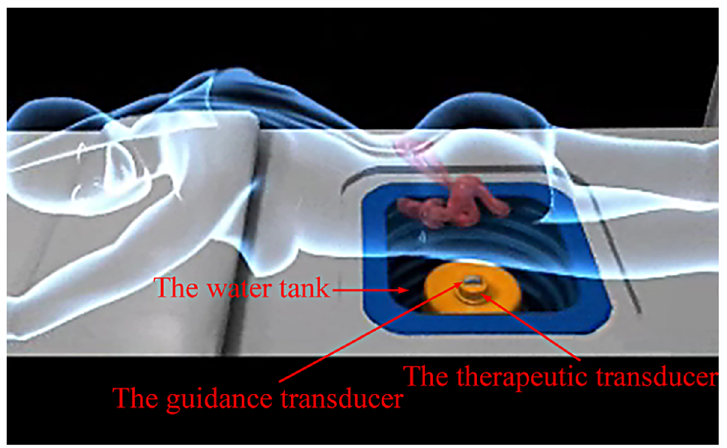
Fig 2. Illustration of the geometry and configuration of the transducers in the HIFU machine.